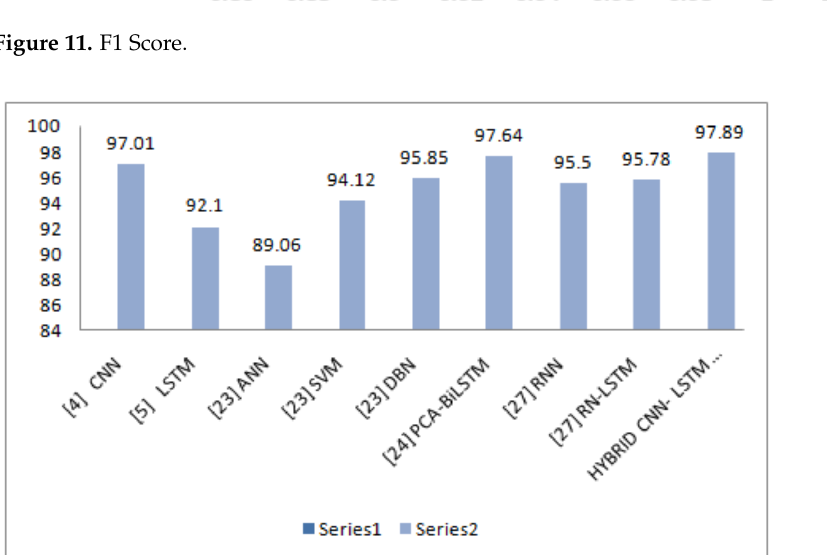
Figure 11. F1 Score.